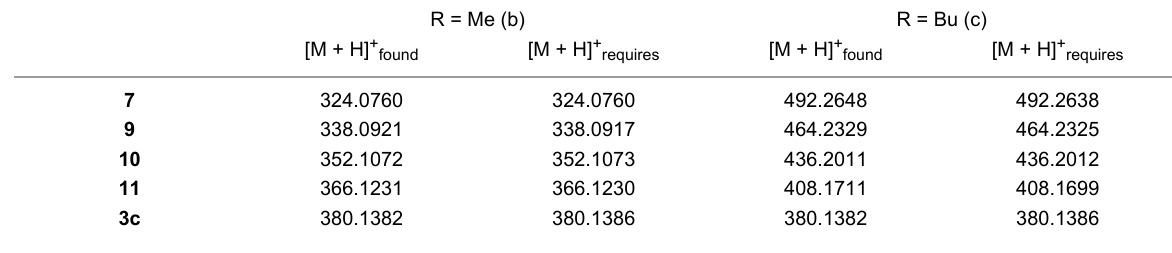
Table 7: Mass spectral characterization of